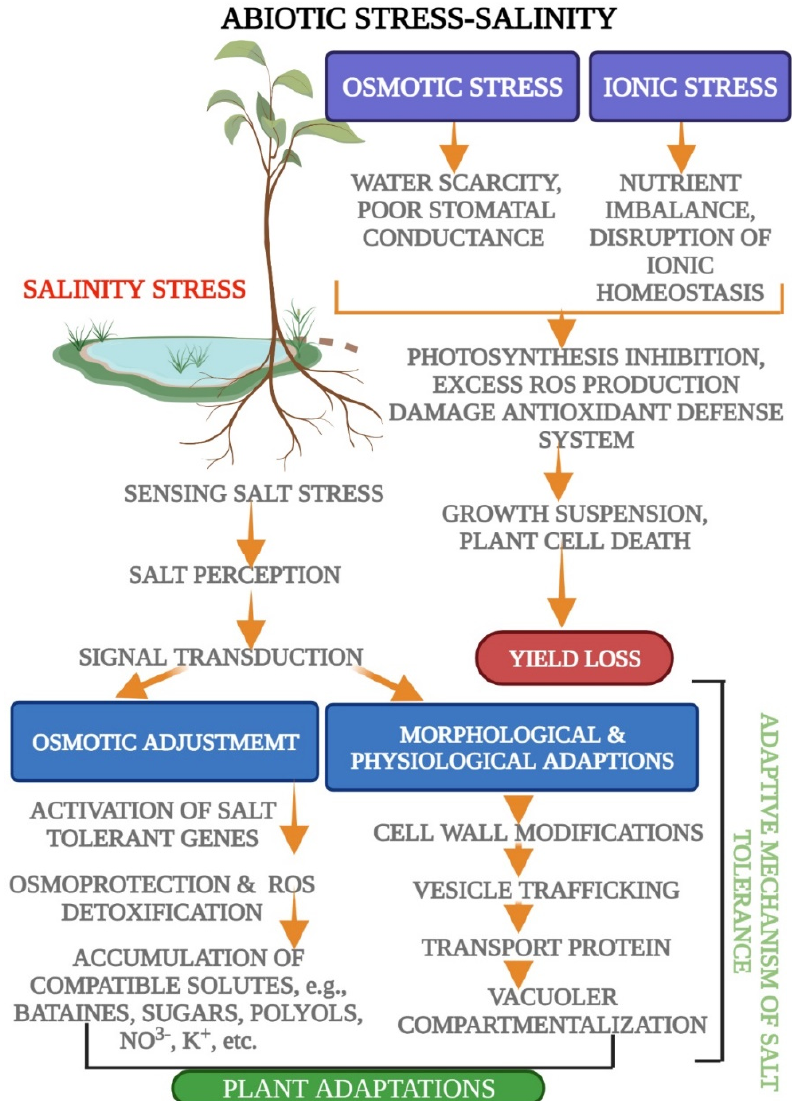
Figure 3. Schematic representation of osmotic and ionic stresses in plants in relation to salt stress. Adaptive mechanisms of plants, including osmotic adjustment and morpho-physiological adaptations, to maintain ionic homeostasis in their cell solutions.